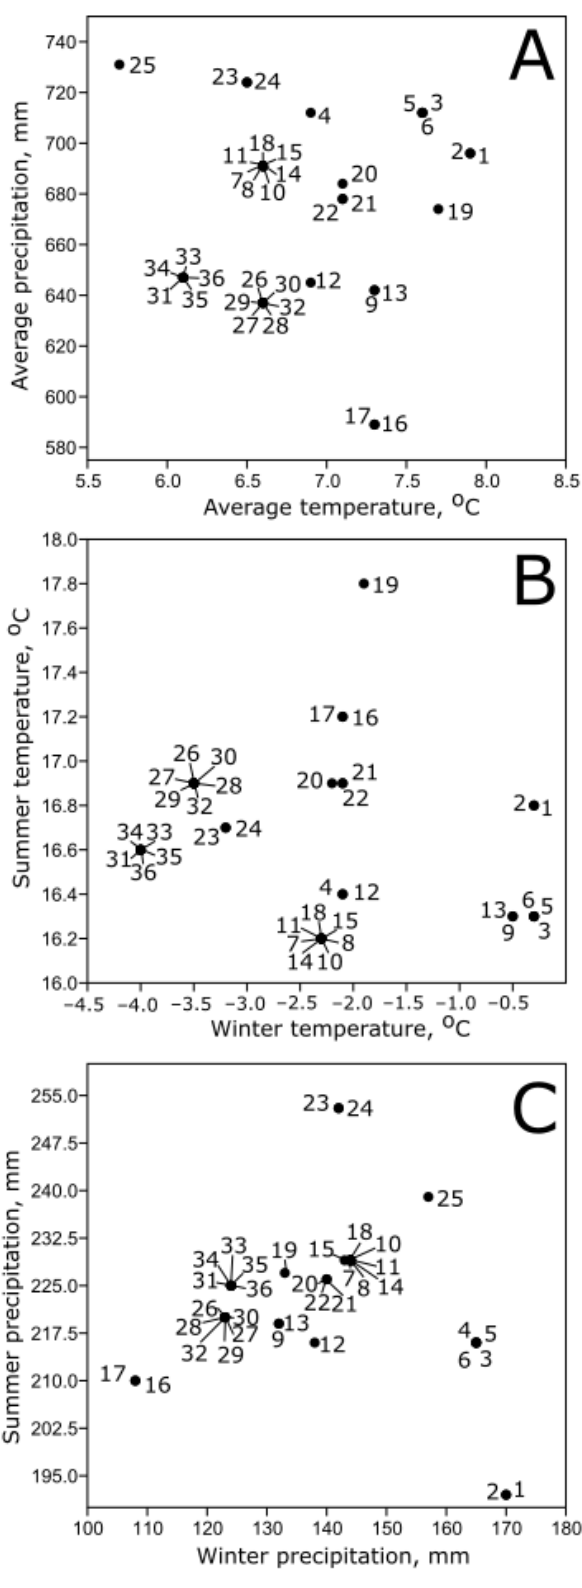
Figure 2. Scatterplots showing ( A ) average precipitations (mm) versus average temperatures (C), ( B ) summer versus winter temperature (C) and ( C ) summer versus winter precipitation (mm) for the 36 sites (site names and location within the Latvia see Table 1 and Figure 1).